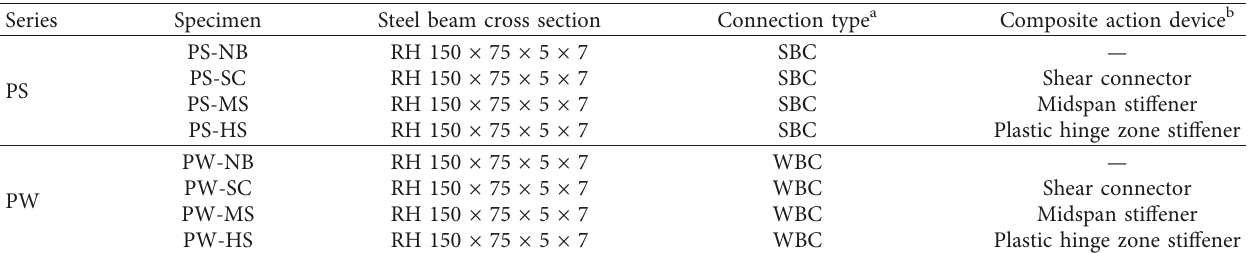
Figure 2: PE Beam in a moment resisting frame. (a) Moment distribution of the beam under earthquake type loading. (b) Column constraint at beam end. (c) Plastic hinge zone stiffener and midspan Table 1: Details of test specimens.